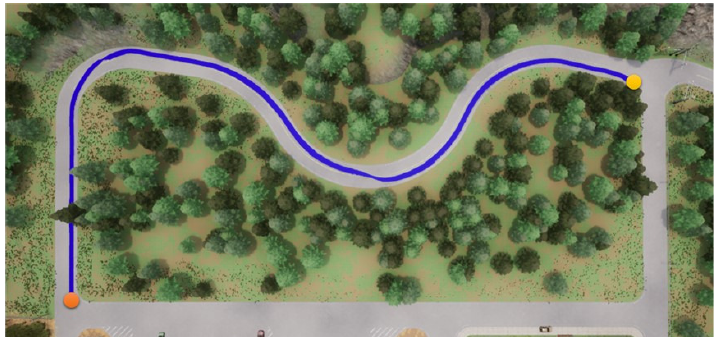
Figure 12. DDPG with an RGB camera for the first testing path.